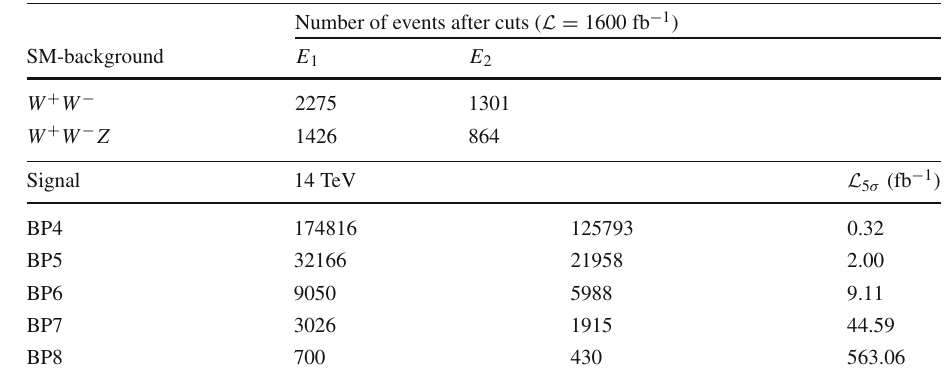
Table 7 The cut-flow for signal and backgrounds along with the required integrated luminosity to achieve 5 σ significance for the μ + μ − → 1 l + 2 j + E T / channel for BP1, BP2 and BP3 at 6 TeV Muon collider